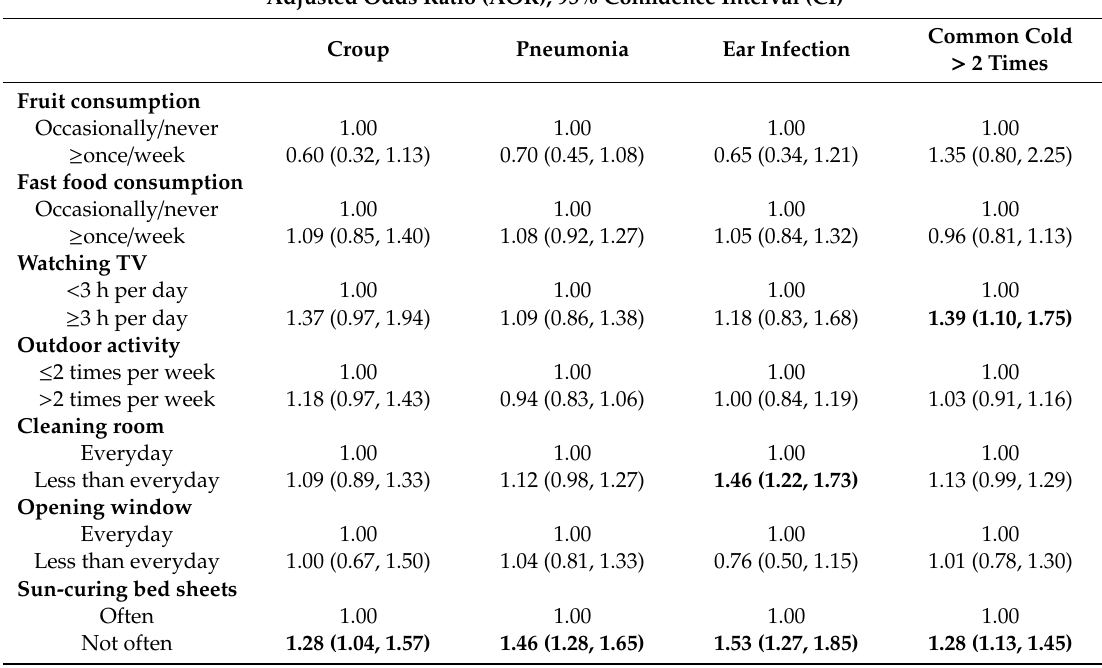
Table 3. Associations of respiratory infections among children with dietary habits, outdoor activity, cleaning habits, sun-curing bed sheets and window-opening